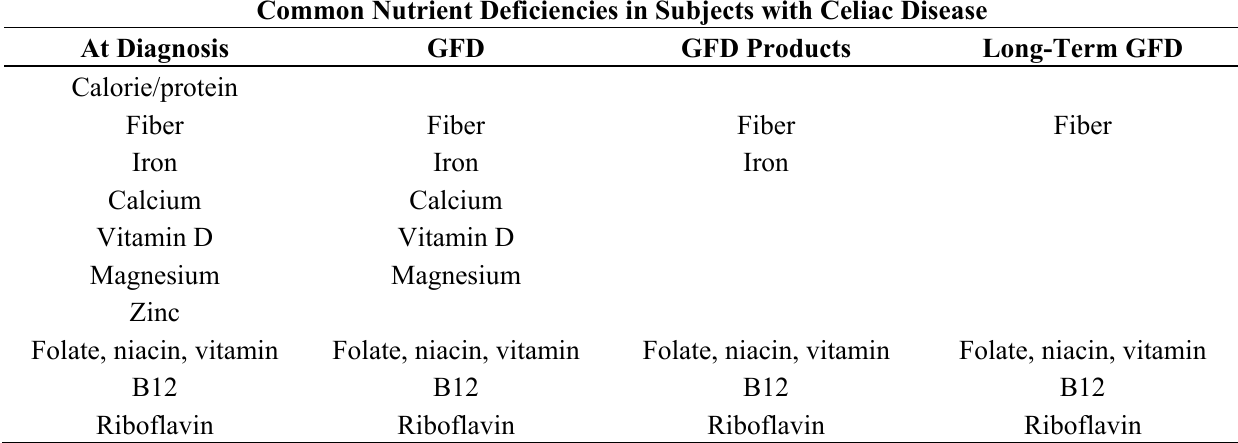
Table 2. Common nutrient deficiencies in adults with celiac disease (CD) at diagnosis and after Gluten-free diet (GFD). Modified from Cynthia Kupper